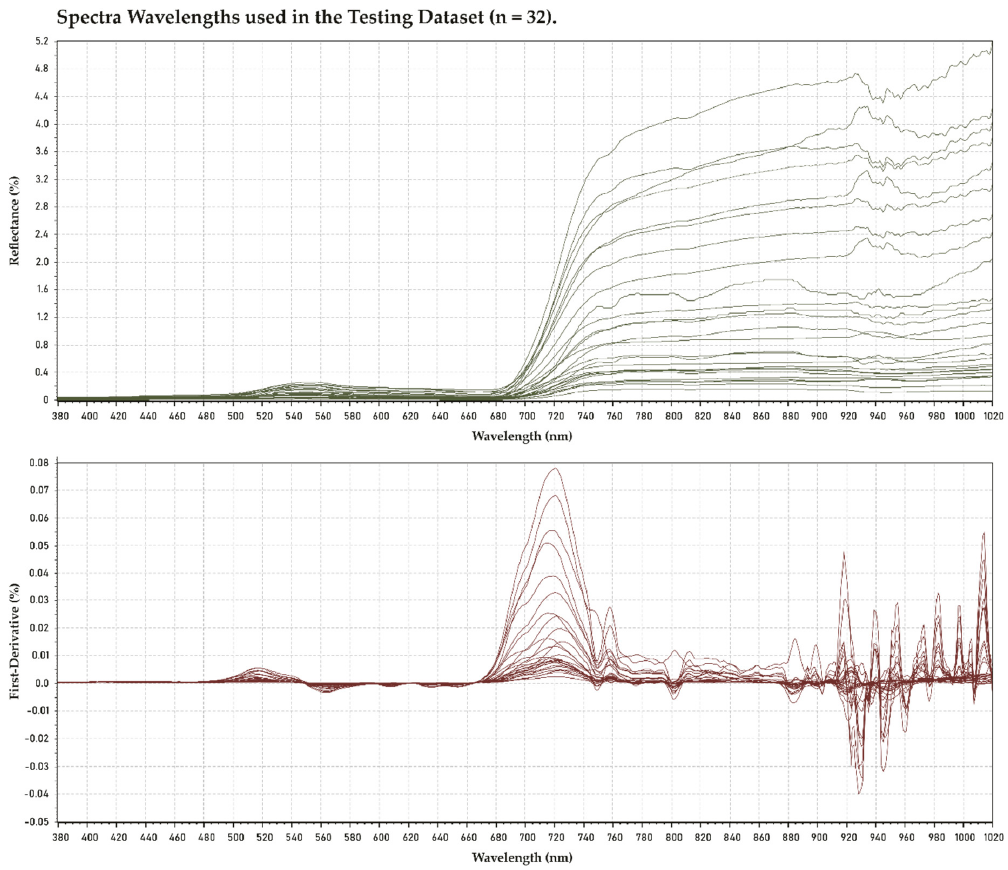
Figure 2. Spectral wavelengths used for testing the machine learning algorithms’ performance. In green are the spectral reflectance, while in dark-red are their respective first-derivatives.